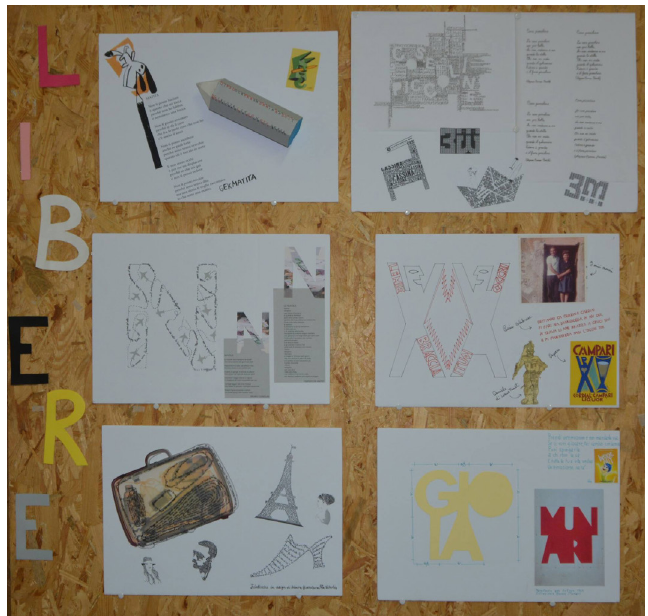
Fig. 2 Parolibere work